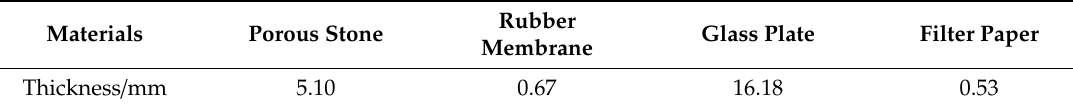
Table 2. Material thickness.